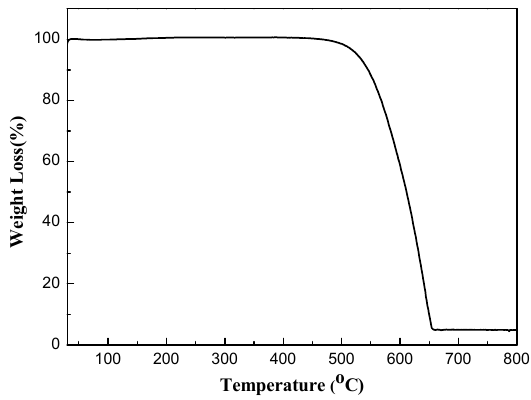
Figure 4. Thermogravimetry (TG) analysis for heating the g-C 3 N 4 from room temperature to 800 °C.